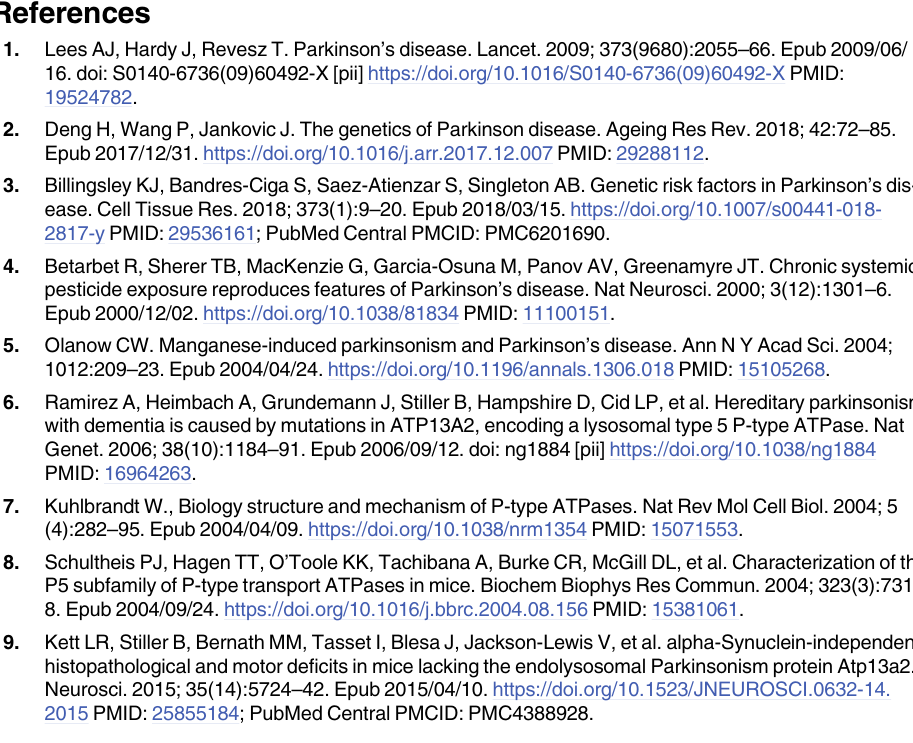
S2 Table. Table of two-way ANOVA data for Fig 5H. Two-way ANOVA analysis of the den- dritic dopamine processes in animals following treatment with the different concentrations of MnCl the results of which are shown in Fig 5H. 2 S1 Fig. Cells overexpressing Atp13a2 show increased autophagosome acidification during adaptive autophagy. (A-C). Images of the individual GFP, mCherry, DAPI and their resulting combined image used to construct the panels shown in Fig 4C. Bar, 10 μ